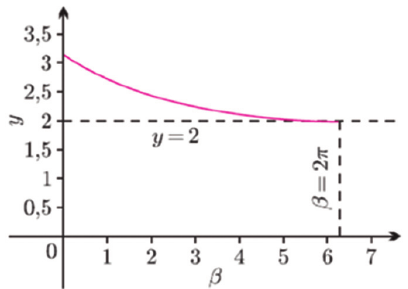
Fig. 8. The graph of function ( ) y (cid:32) (cid:83) (cid:69) (cid:4) for the conical parallel of latitude circles (Kopacz 2010)